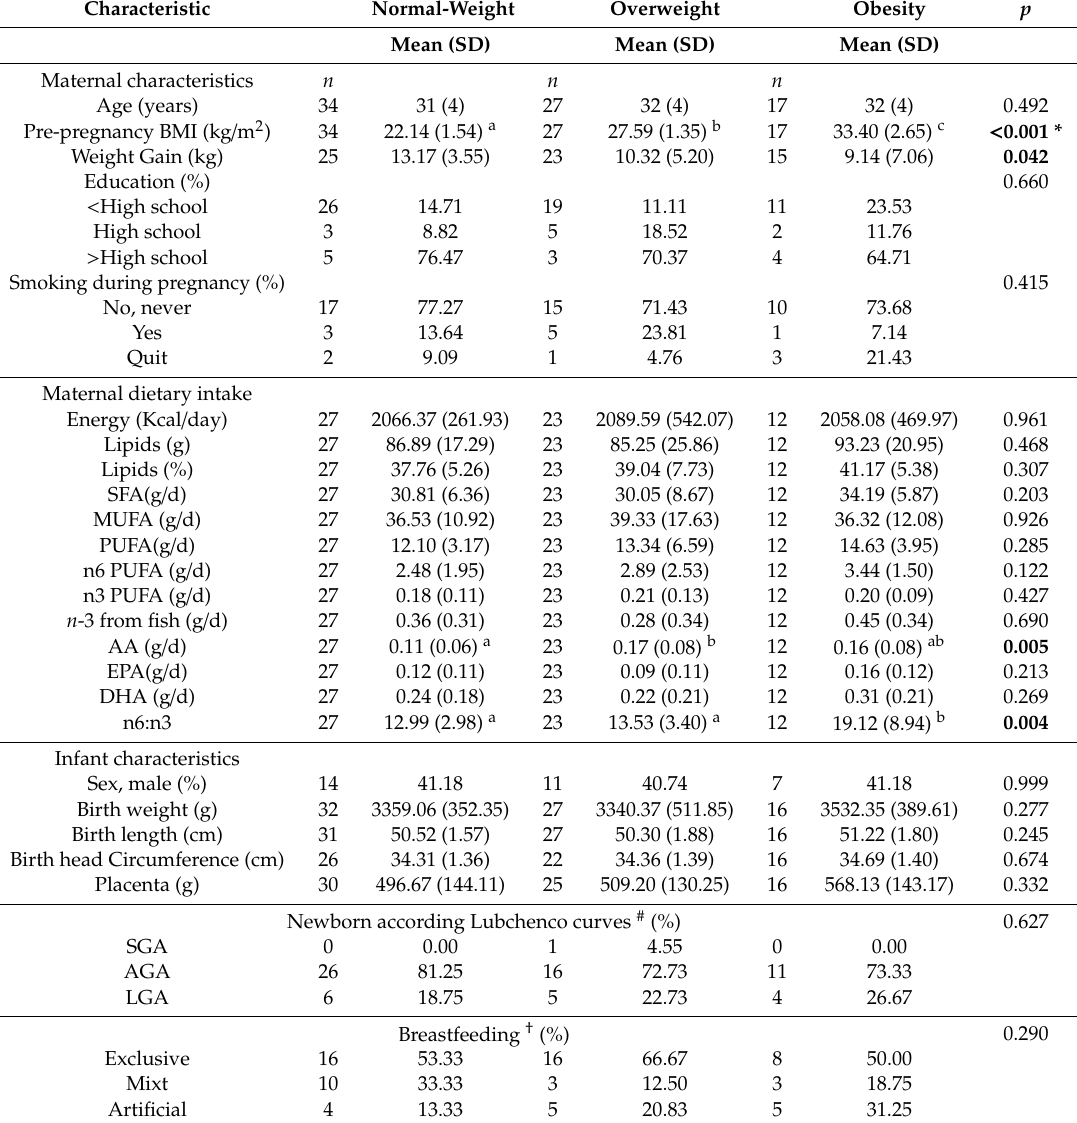
Table 1. Characteristics of the